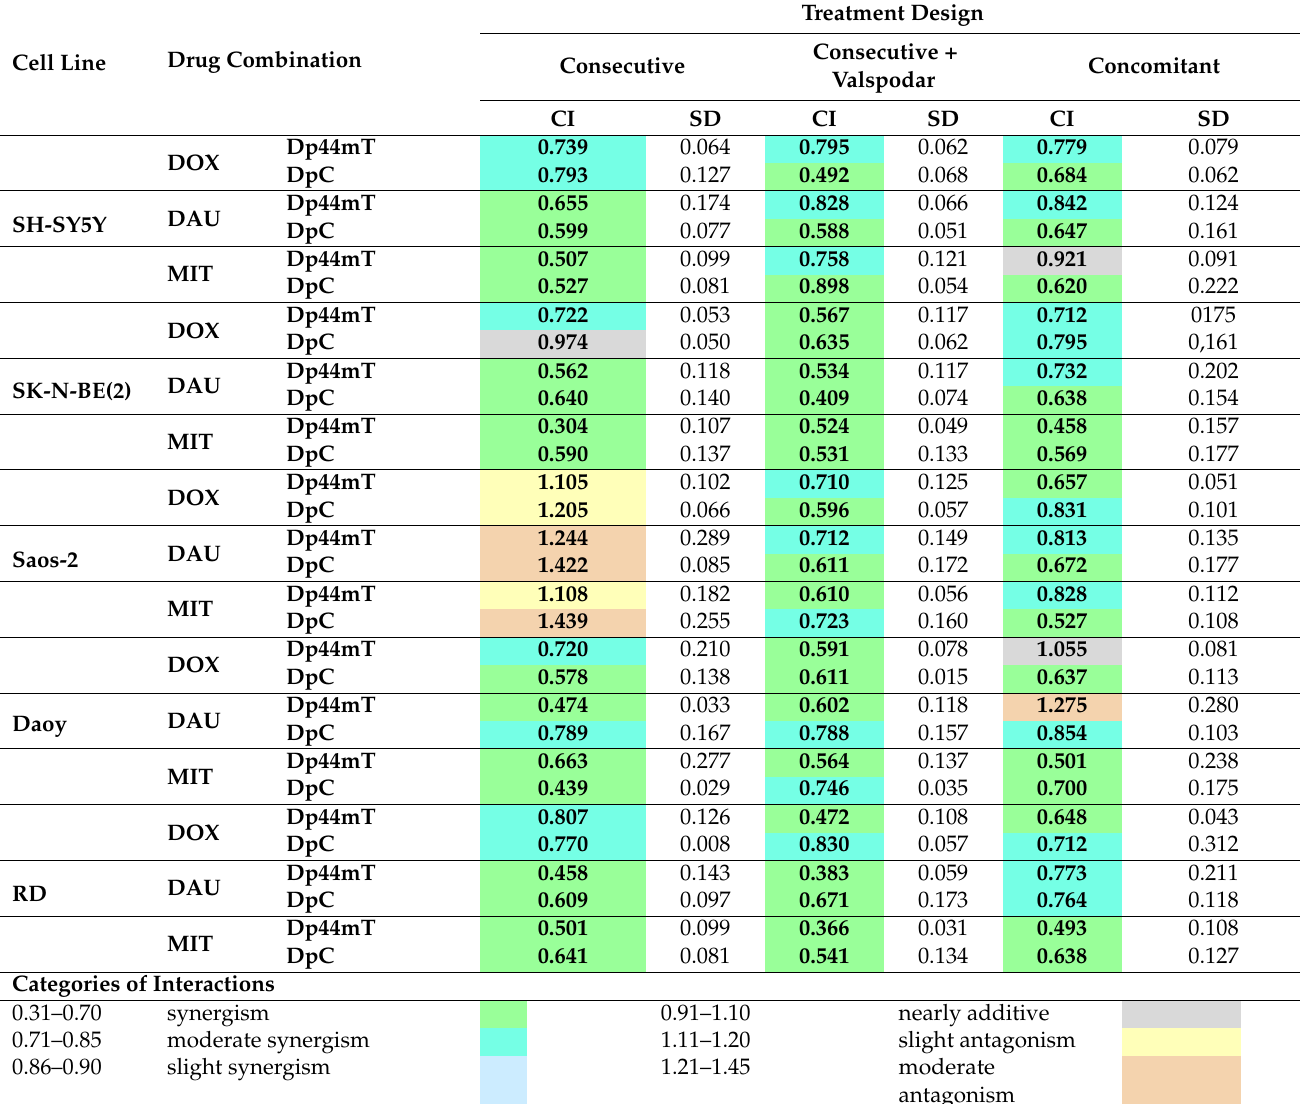
Table 2. Quantitative assessment of the interactions between